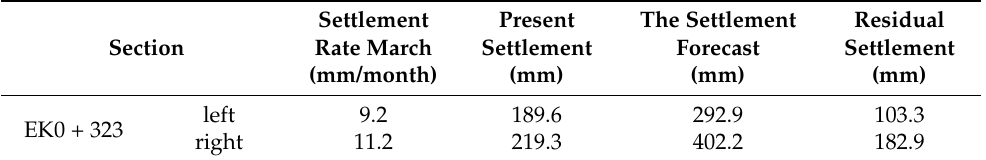
Table 3. Settlement forecast.